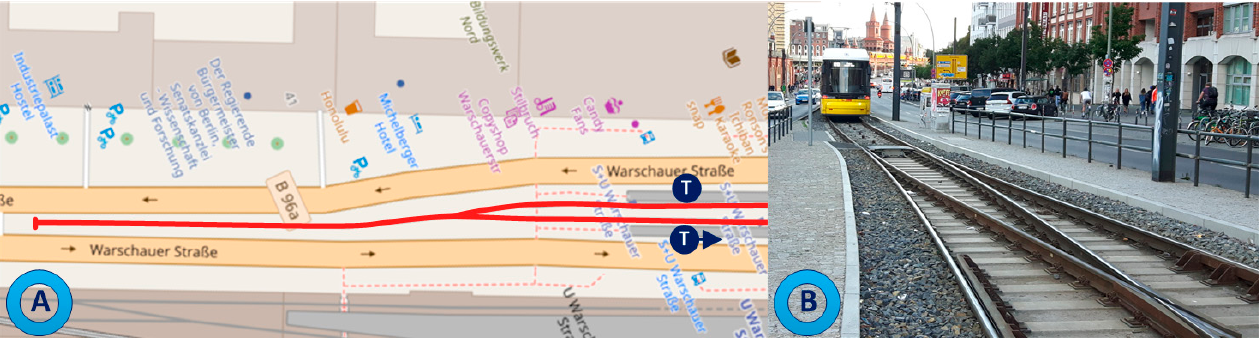
Figure 5. Terminating a tram route without applying a tram loop—Warsaw Street, Berlin, Germany: ( A ) own study based on openstreetmap.org; ( B ) own study.